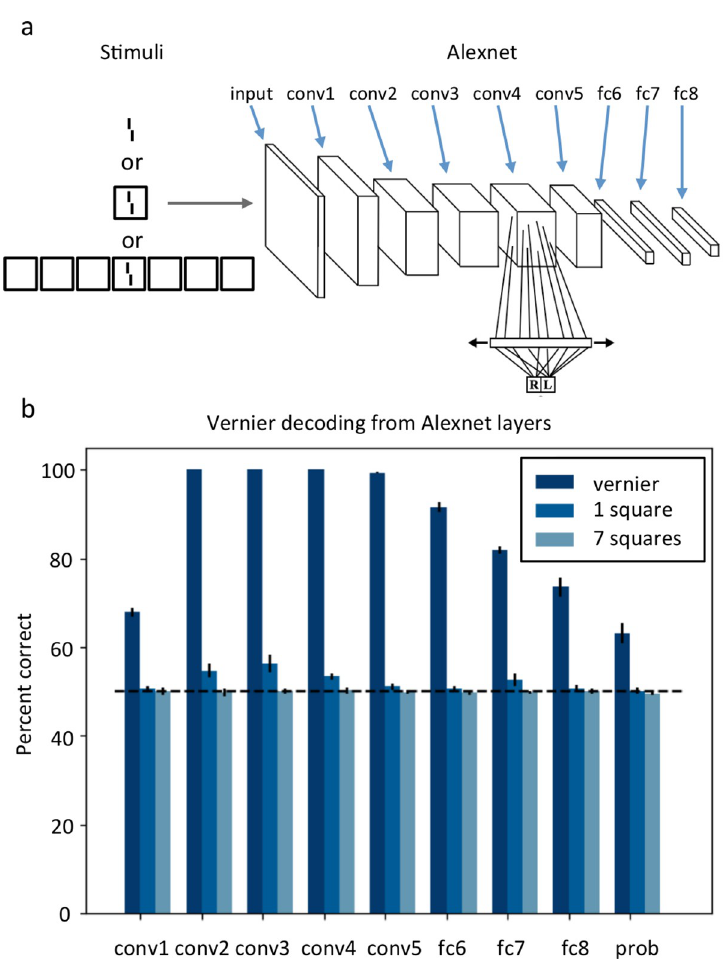
Fig 11. Alexnet. a. Stimuli consisted of either verniers, verniers surrounded by a single square or verniers with seven squares. The stimuli had varying sizes, vernier offsets and positions. Alexnet’s architecture and a classifier are shown on the right (there was a classifier at each layer). The boxes correspond to the input (leftmost box) and activated neuron layers (see [49] for the detailed architecture of Alexnet). We trained softmax classifiers on all ReLU layers following the convolution layers and the last fully connected layer to detect vernier orientation from the layer’s activity. b. Accuracy of softmax classifiers trained to detect vernier orientation from different layers in the deep neural network Alexnet. Across all layers, the offsets in crowded stimuli (1 square flanker) are always better detected than offsets in uncrowded stimuli (7 square flankers). This runs contrary to human performance. NB. This model only produces percent correct, there is no output